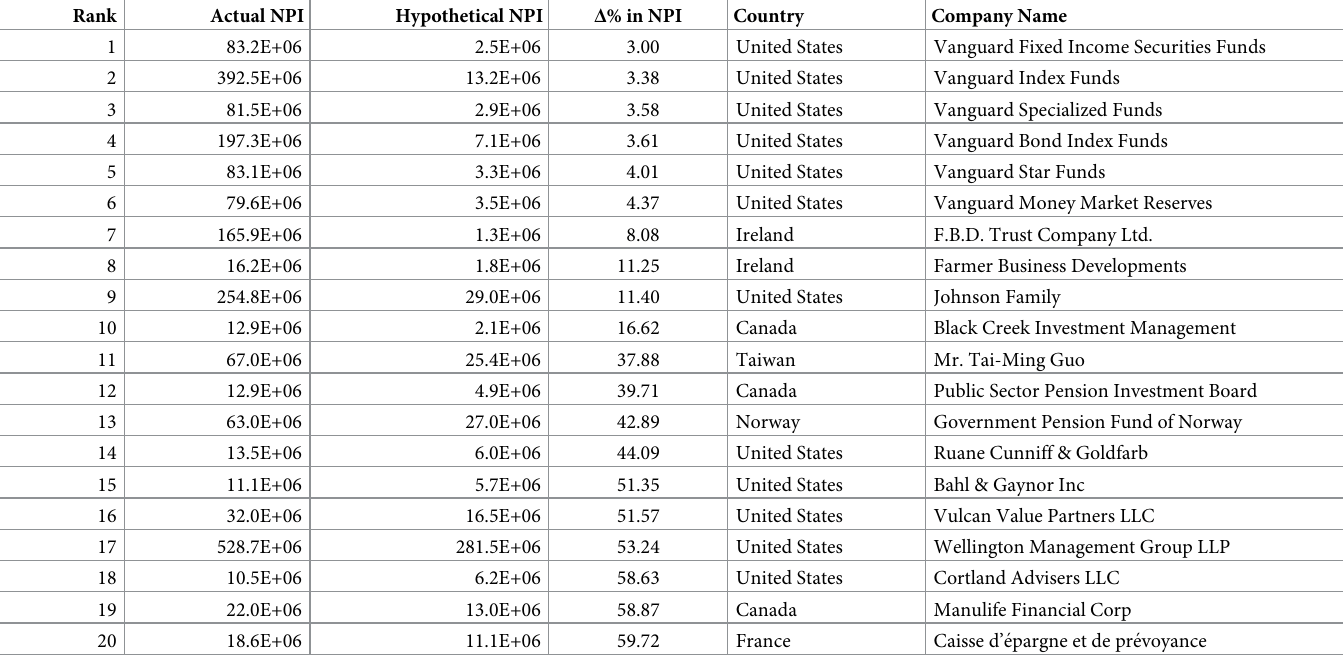
Table 8. Equity funds and inflated corporate control over non-green